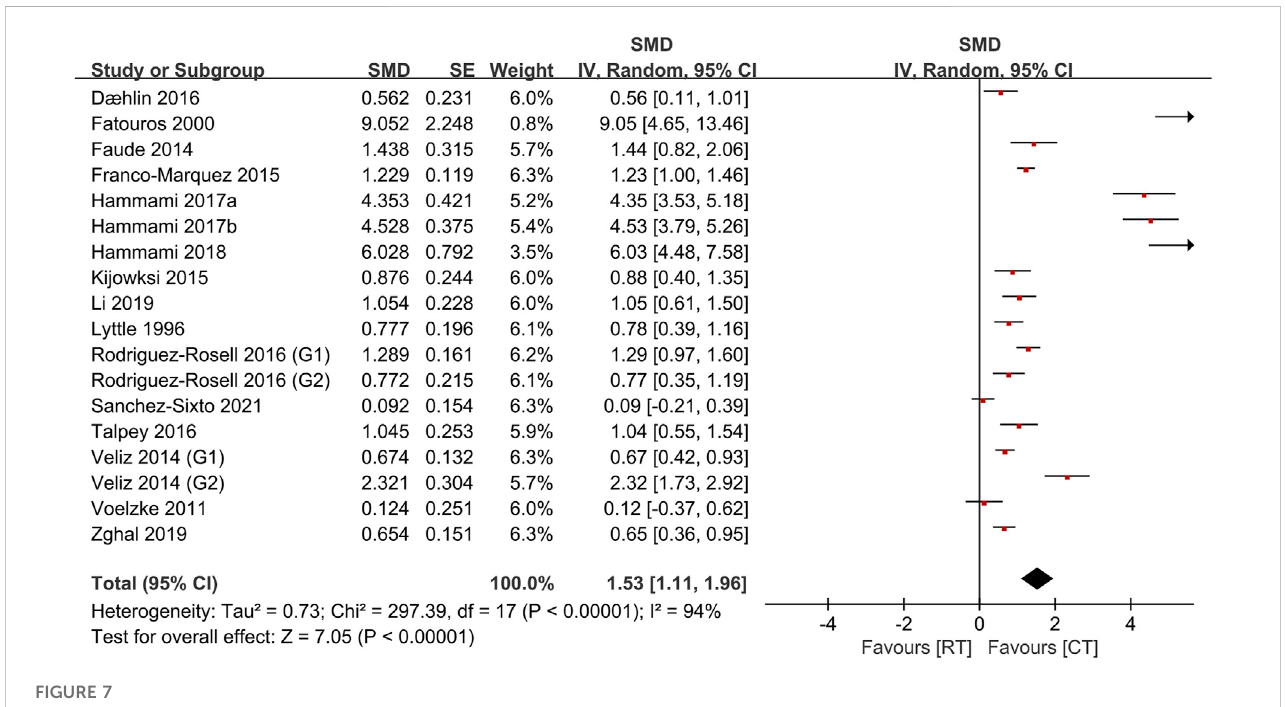
FIGURE 7 Effects of complex training (PLT) on maximum strength.